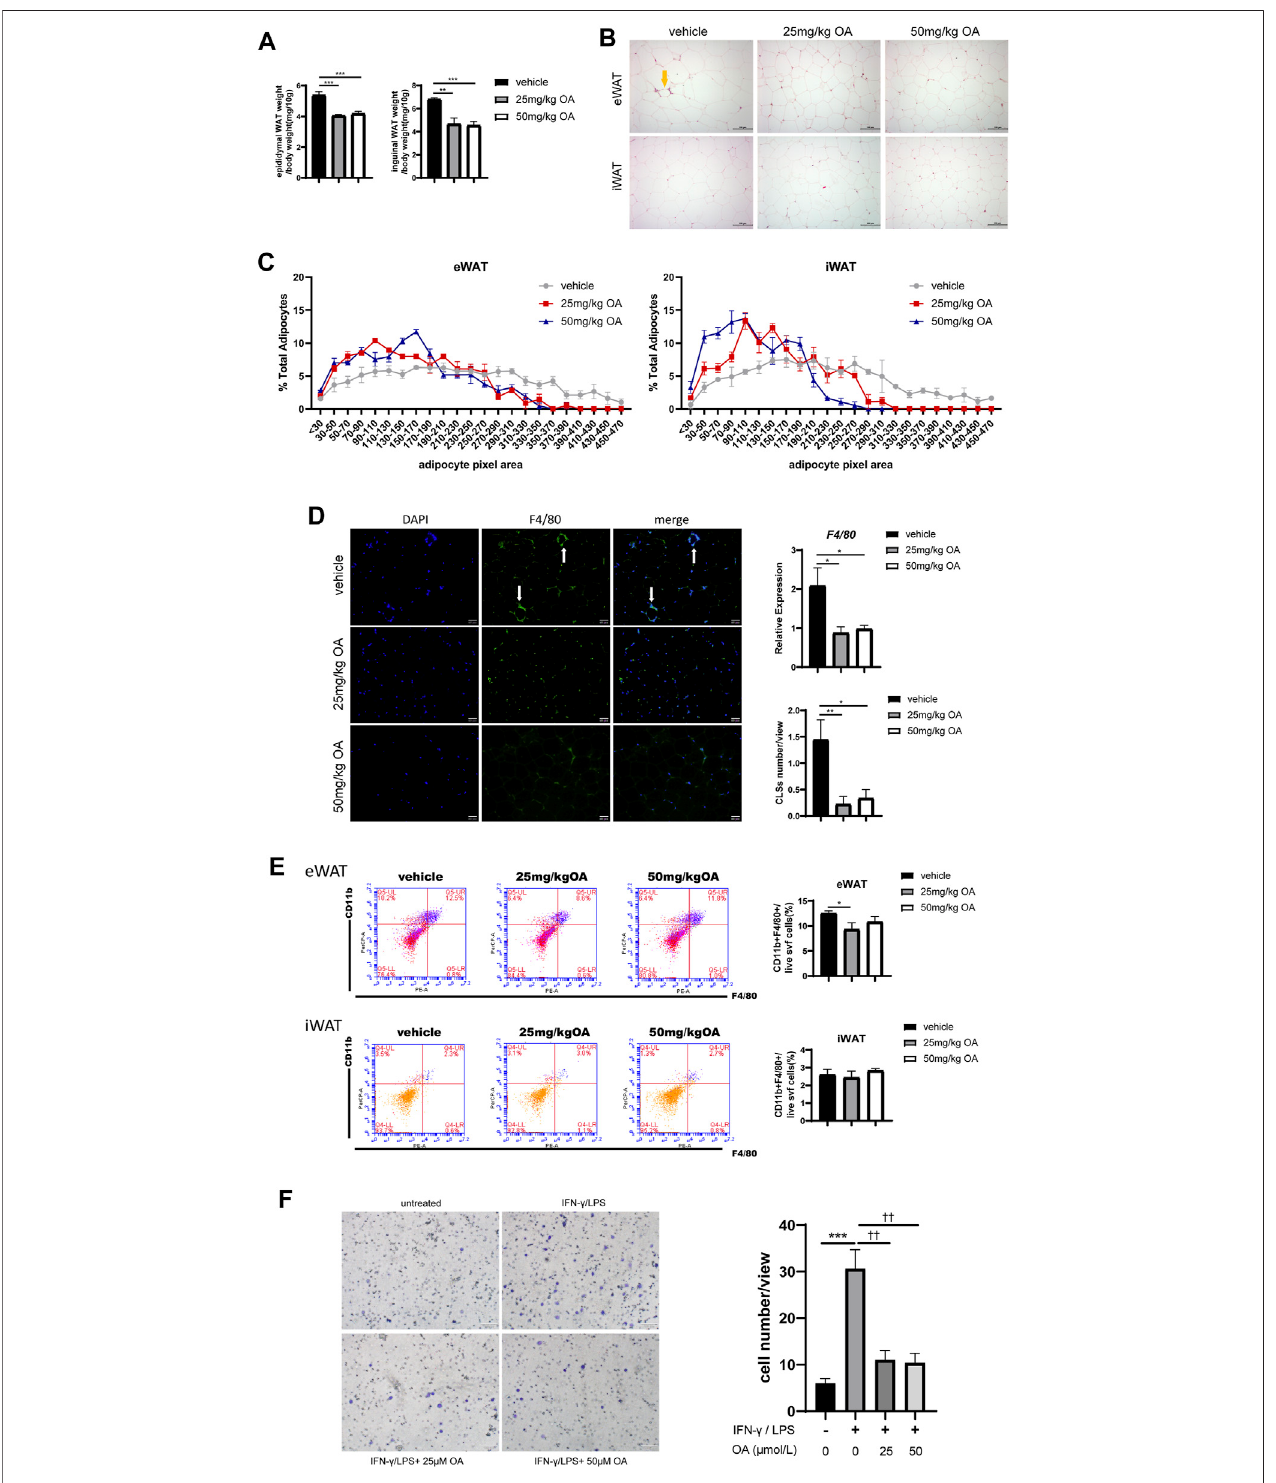
FIGURE2| OAdiminishesadipocytesizeandreducesmacrophagein fi ltrationtoeWATinDIOmice. (A) RatioofeWAT/iWATtobodyweightofmice( n (cid:1) 7). (B) HE staining results of eWAT and iWAT. Scale bars (cid:1) 100 µm. (C) Statistics of the adipocyte area ( n (cid:1) 51 – 76). (D) F4/80 immuno fl uorescence staining, mRNA expression ( n (cid:1) 5)andCLSsstatistics( n (cid:1) 9)ofeWAT.Scalebars (cid:1) 50 µm. (E) Representative plotsandstatistics ofFCManalysis:totalATMstotheSVFofeWATandiWAT( n (cid:1) 5). (F) Transwell results ofBMDMs, scale bar (cid:1) 100 µm ( n (cid:1) 6).* p < 0.05, ** p < 0.01, *** p < 0.001,**** p < 0.0001vs. vehicle or control incubations, †† p < 0.01vs. IFN- γ /LPS stimulated